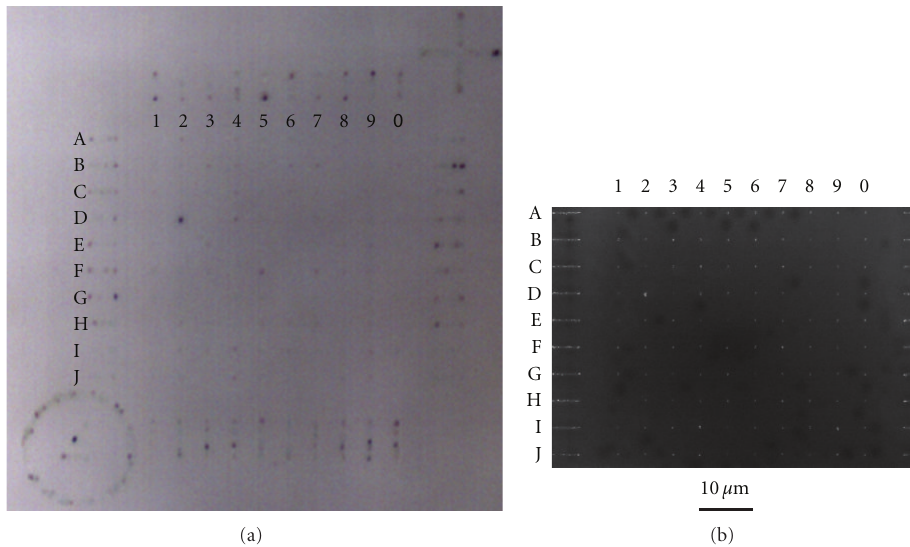
Figure 2: (a) White-light reflectance microscopy image and (b) SEM image of a patterned array of 85 nm nanocube clusters on silicon. The images were scaled to the same magnification. The row (A–J) and column (1–9, 0) indicators were added to the images using Adobe Illustrator